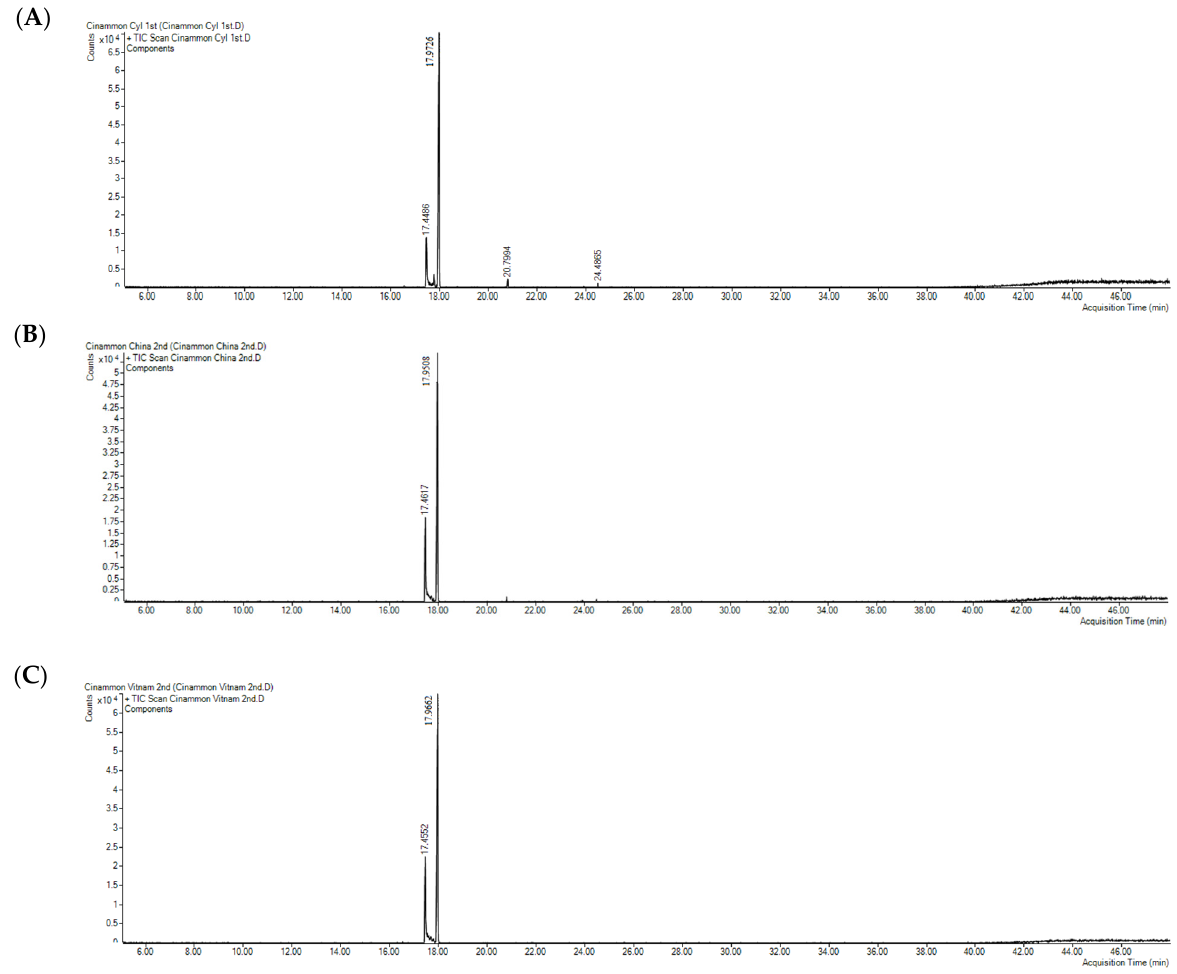
Figure 1. GC chromatograms of the EOs obtained by hydrodistillation from C. verum ( A ), C. cassia ( B ) and C. loureiroi ( C ). Table 2. Components of the EOs of three cinnamon species.